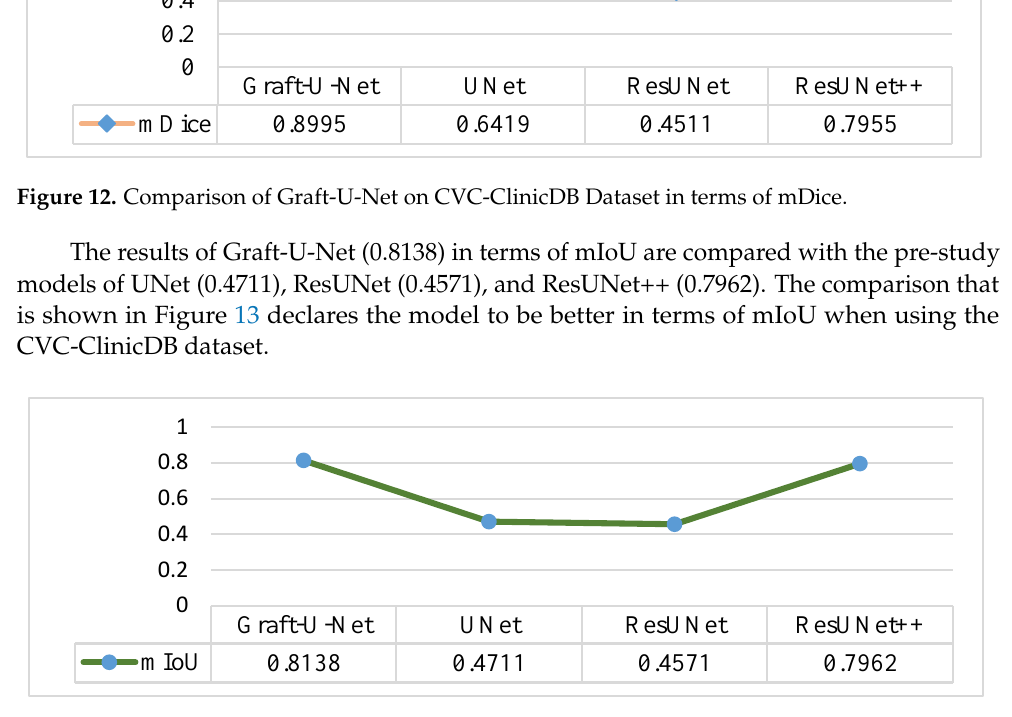
Figure 13. Comparison of Graft-U-Net on CVC-ClinicDB Dataset in terms of mIoU. The results of Graft-U-Net (0.8785) in terms of Recall are shown in Figure 14. The results are compared with the pre-study models of UNet (0.6756), ResUNet (0.5775), and improved using the CVC-ClinicDB dataset.